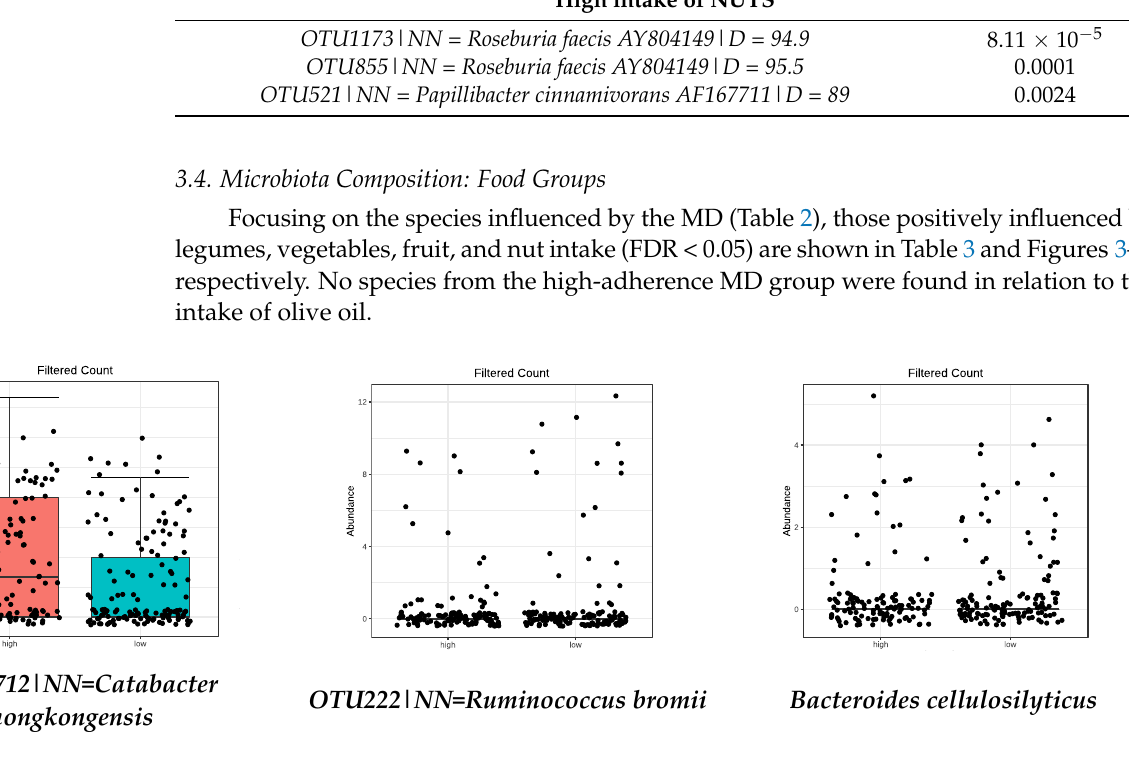
Figure 3. Bacterial species that were significantly more abundant in the group with high LEGUMES intake (FDR < 0.05) by metagenomeSeq test. Red boxes represent participants with a higher adherence to the MD and blue boxes low adherence.